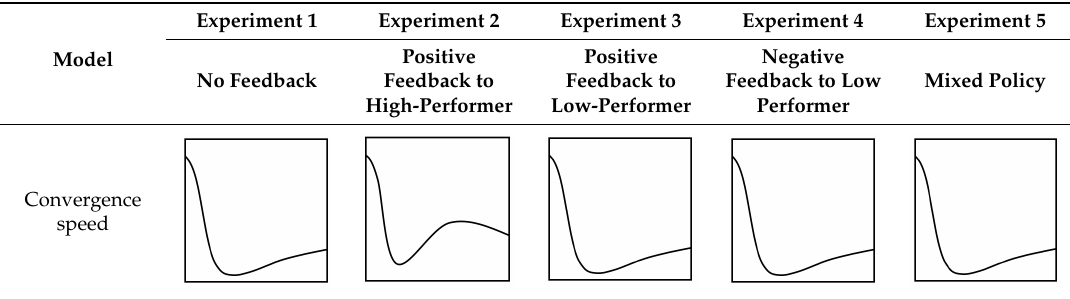
Table 8. Summation of the simulation results.